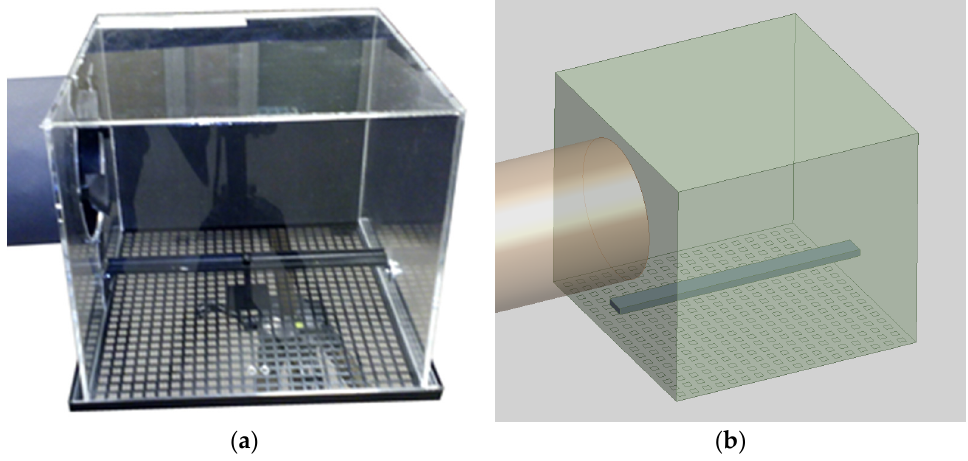
Figure 7. Air diffuser panel ( a ) real view; ( b ) used for